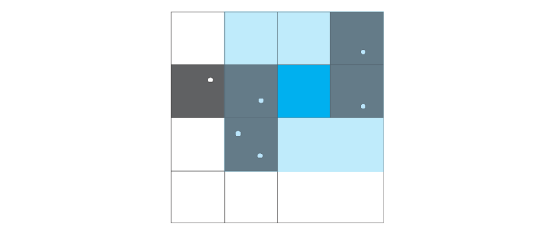
Figure 8: The closest border with a black node and the dark blue node must lie in the light blue area